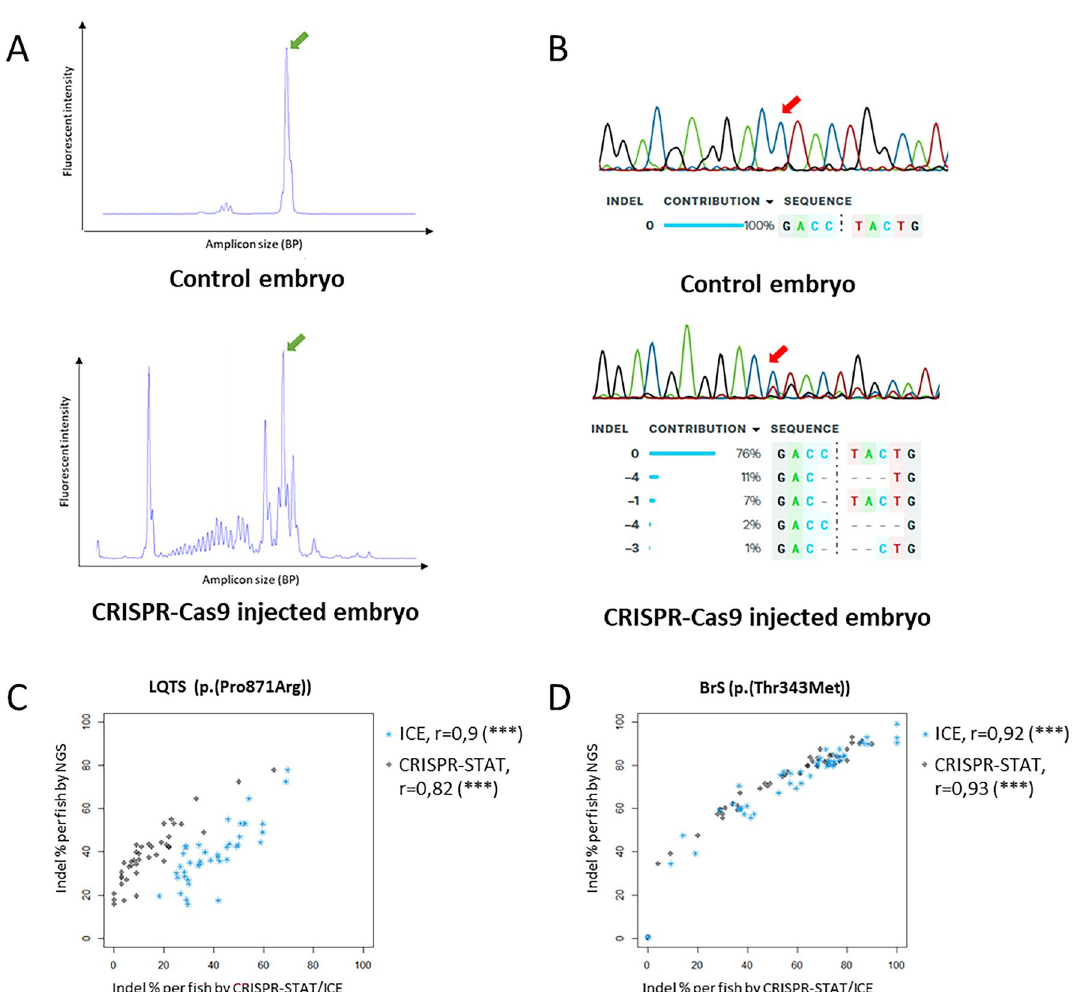
Figure 1. Comparison of indel detection methods. ( A ) Representative traces for CRISPR-STAT, top: sample from uninjected control embryo, bottom: sample from embryo injected with CRISPR-Cas9 components, green arrow: peak from wildtype amplicon, all other peaks in injected embryo represent different indel events. ( B ) Representative Sanger chromatograms and ICE analysis results, top: sample from uninjected control embryo, bottom: sample from embryo injected with CRISPR-Cas9 components, the trace from the injected embryo shows additional peaks on the right side of the cut site (red arrow), representing different indels, which are detected by ICE. ( C,D ) Correlation between Inference of CRISPR Edits (ICE) (blue symbols), CRISPR-STAT (black symbols) and NGS for LQTS ( C ) and BrS locus ( D ). Each symbol represents the indel percentage calculated for the individual embryo. Indel insertions/deletions, NGS next generation sequencing, BP base